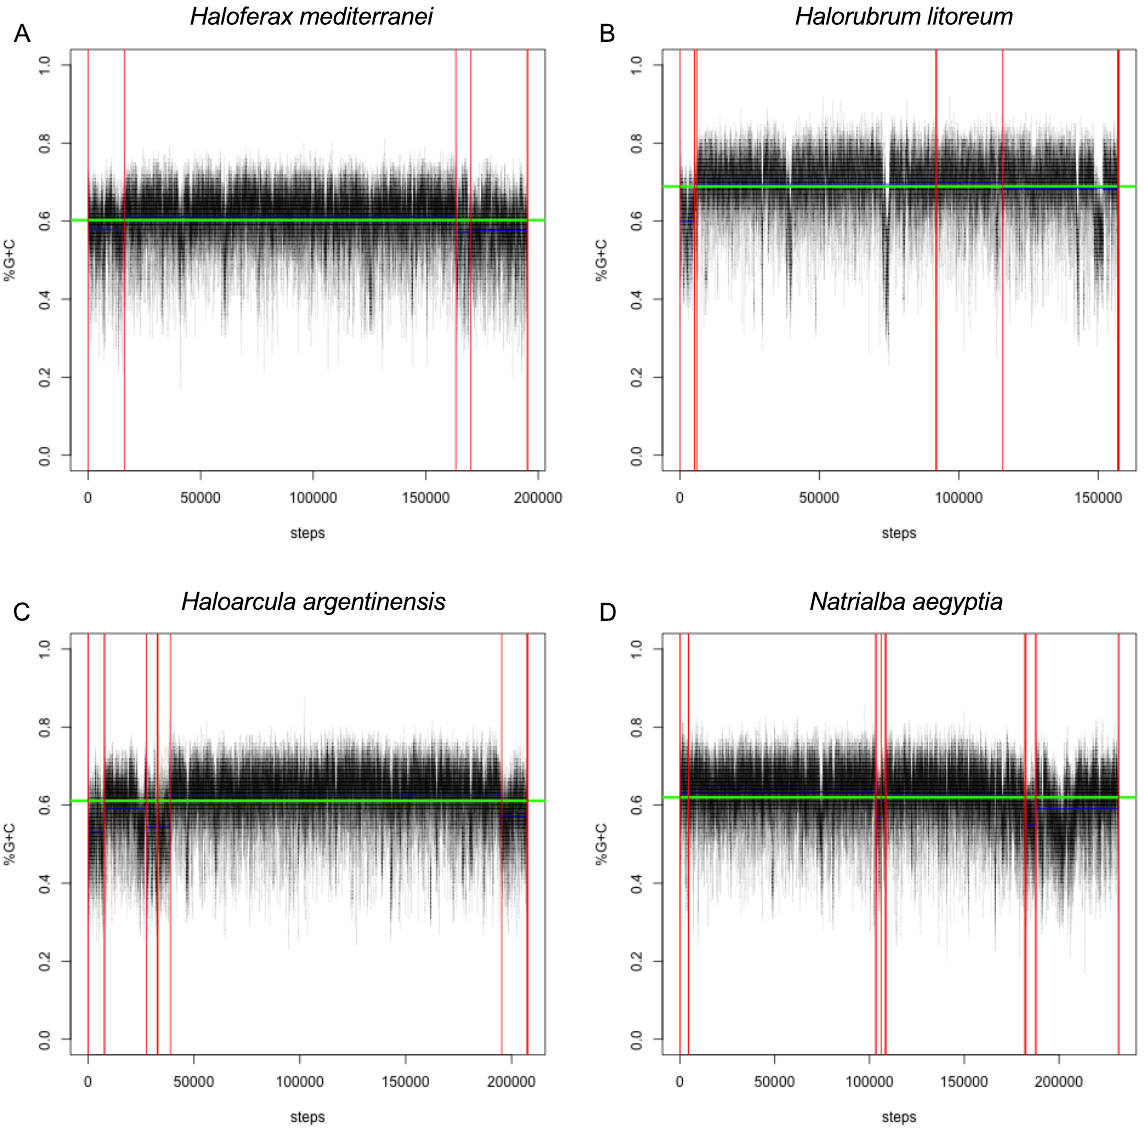
Figure 7. Sliding-window G + C content analysis. Representative G + C content plots for (A) Haloferax mediterranei , (B) Halorubrum litoreum , (C) Haloarcula argentinensis , and (D) Natrialba aegyptia . Each of these four species is a representative from the four most populous genera in the set, which collectively contain 66% of the organisms in the study. Black line represents calculated G + C percent for each 100 bp window. Contig boundaries are represented as vertical red lines, contig mean G + C as horizontal blue lines, and genome mean G + C as a horizontal green line. The horizontal axis displays the number of 20 bp steps taken along the genome. For all G + C plots see Data Dryad package [67].